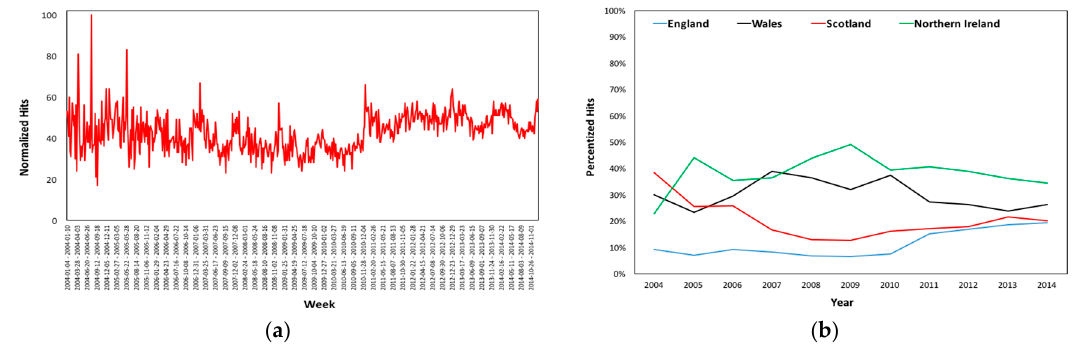
Figure 7. Erythromycin’s ( a ) Normalized Hits in the UK and ( b ) Regional Percentized Hits Averages 2004–2014.